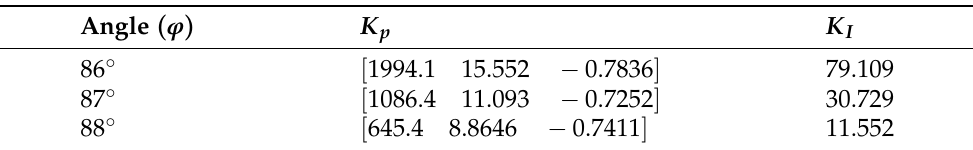
Table 5. Parameters of LMI pole placement controllers designed for various damping angle (Elliptic region).